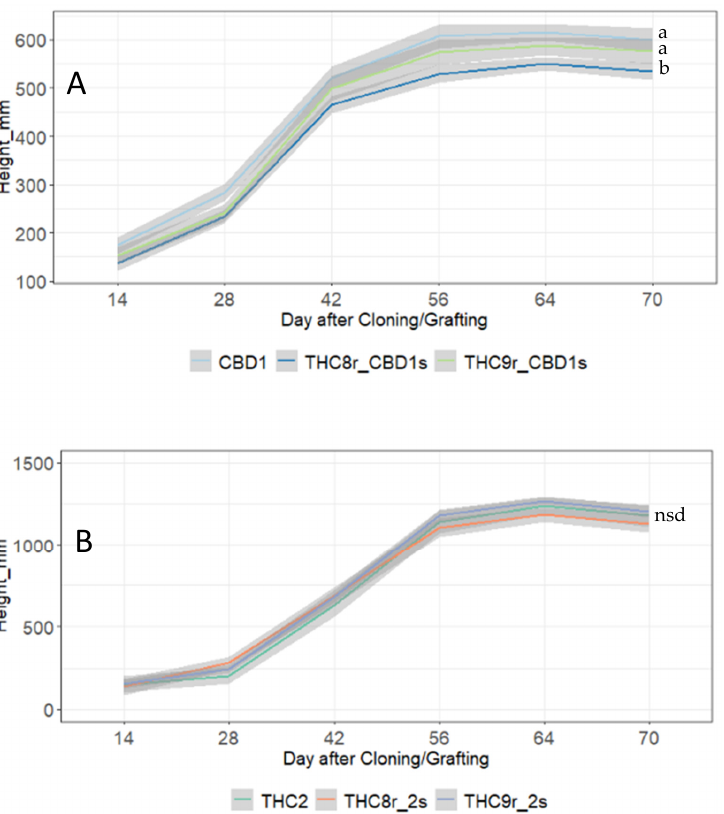
Figure 3. ( A ) Height of ungrafted CBD1 plants and grafted CBD1 scions on THC9 and THC8 root ‐ stocks. ( B ) Height of ungrafted THC2 plants and grafted THC2 scions on THC9 and THC8 root ‐ stocks. N = 5–8 and Letters above the bars denote significant differences (Tukey HSD, p =< 0.05), nsd = no significant difference. The THC2 scions grafted to THC8 rootstocks (THC8r_2s) showed reduced internode lengths compared to THC2, but no other significant differences were observed between this graft and the non ‐ grafted THC2 plants (Table 4). The combination of the THC9 root ‐ stock and the THC2 scion (THC9r_2s) produced a number of favourable morphological differences. Specifically, in THC9r_2s plants, the branches were significantly longer, but the internode lengths on the branches were reduced, and there were more nodes per branch (Table 4). There were on average 22% more inflorescences on the THC9r_2s grafted